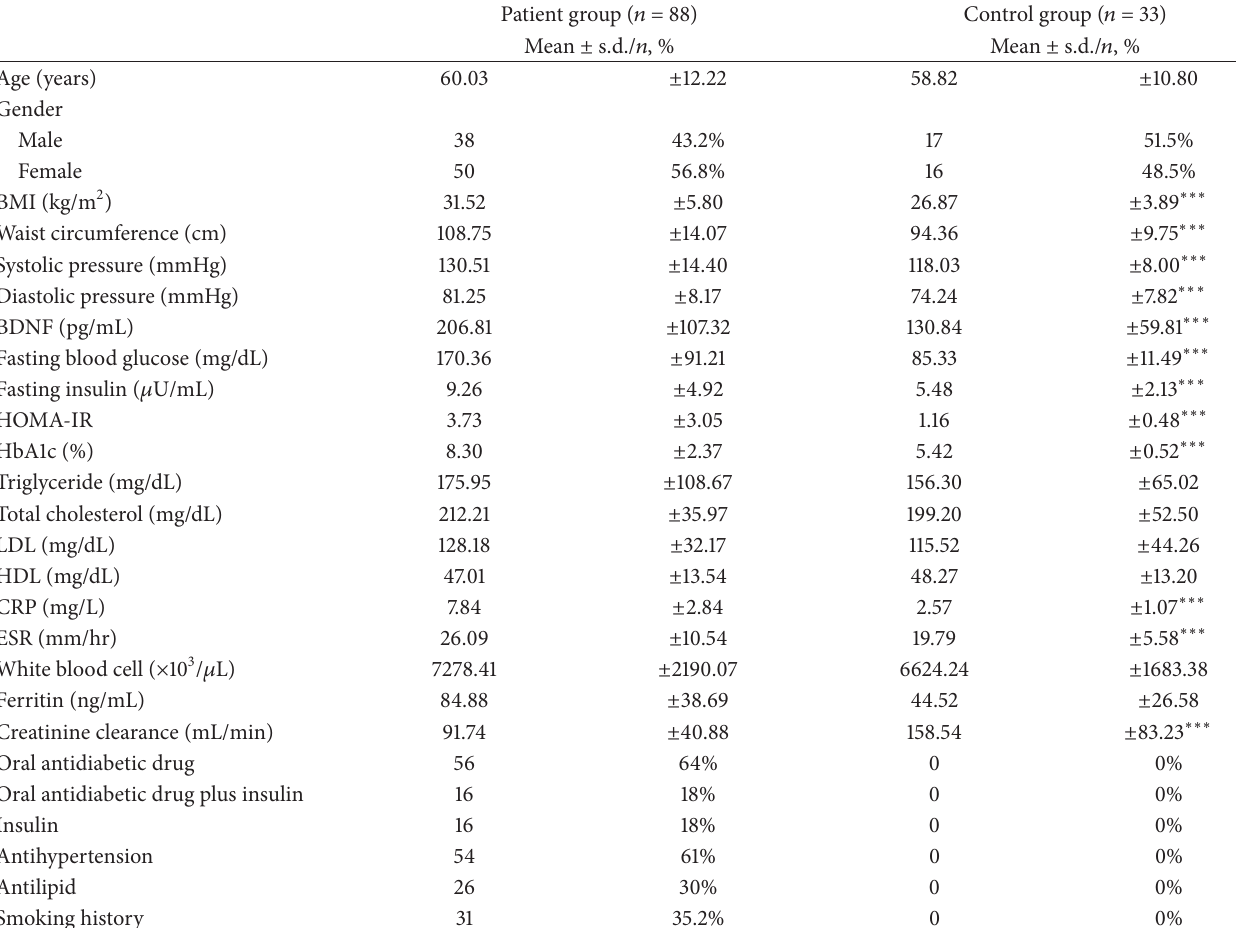
Table 1: Clinical characteristics of patients and controls.